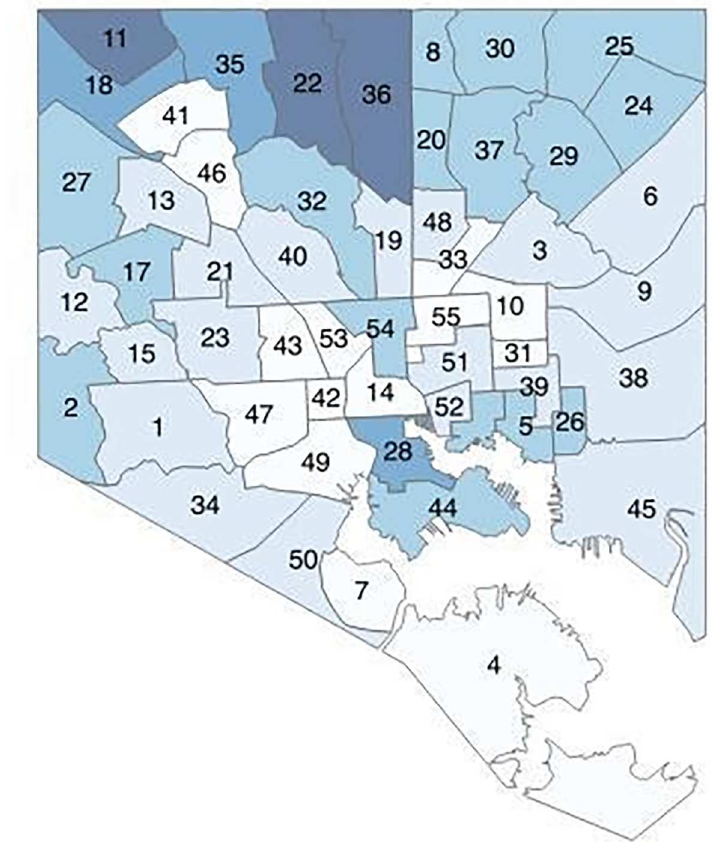
Fig 2. 2013 Baltimore CSAs by life expectancy. Darker blue is longer life expectancy. Numbers refer to CSA names.